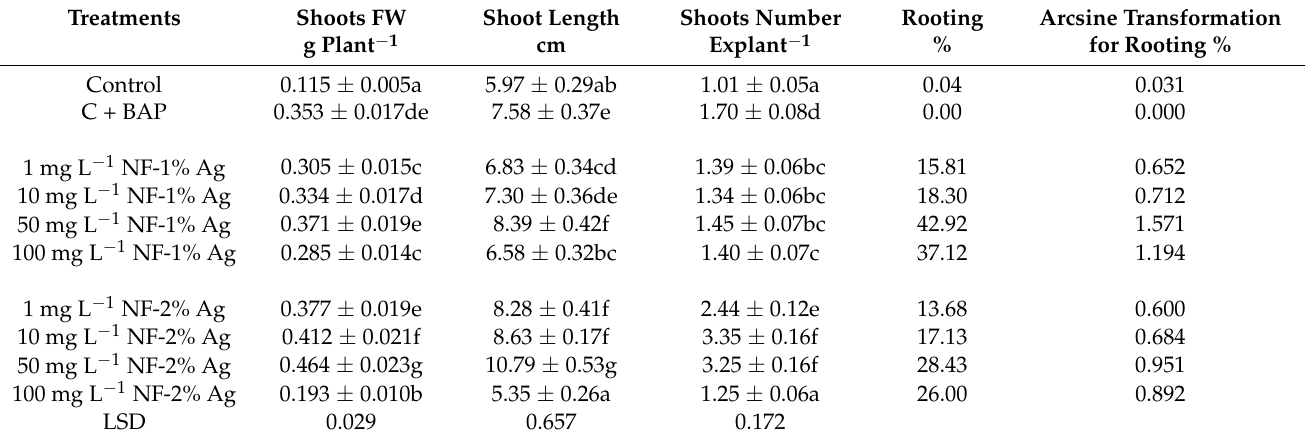
Table 1. Morphological parameters of in vitro grown Stevia rebaudiana plantlets on PGR-free medium and medium supplemented with BAP and amino acid nanofibres in various concentrations (1, 10,